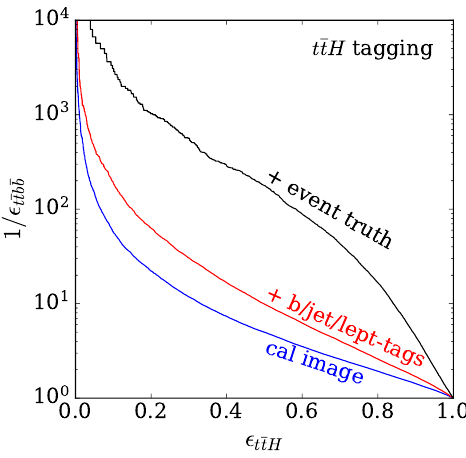
Figure 15: ROC curves for t ¯ tH with calorimeter information only, physically acces- sible information and with MC truth